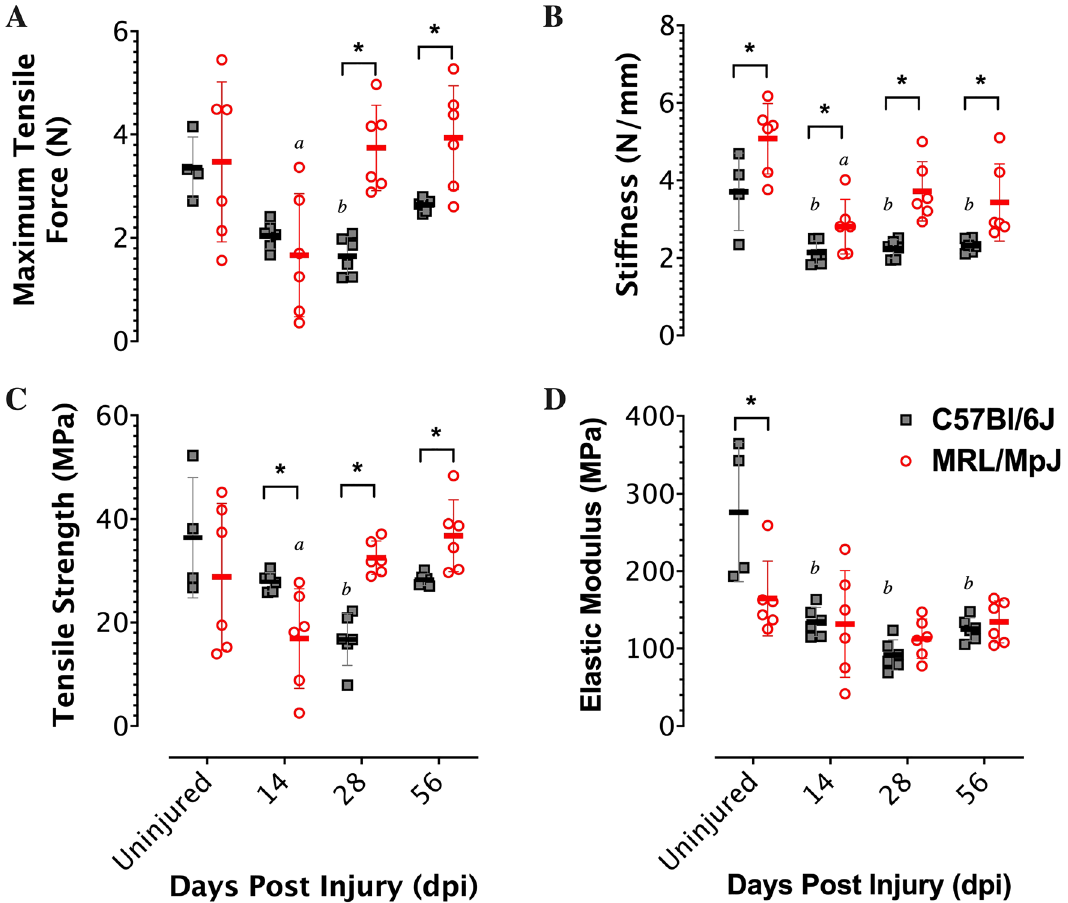
Figure 3. MRL flexor tendons heal with accelerated recovery of strength and stiffness ( A ) Maximum force, ( B ) strength, ( C ) stiffness and ( D ) elastic modulus determined from displacement-controlled tensile testing of uninjured and injured flexor tendons of C57BL/6 J and MRL mice (N = 4–6). Asterisks indicate significant mouse strain differences ( p < 0.05). a and b indicate significant differences ( p < 0.05) from uninjured within C57 and MRL mouse strains